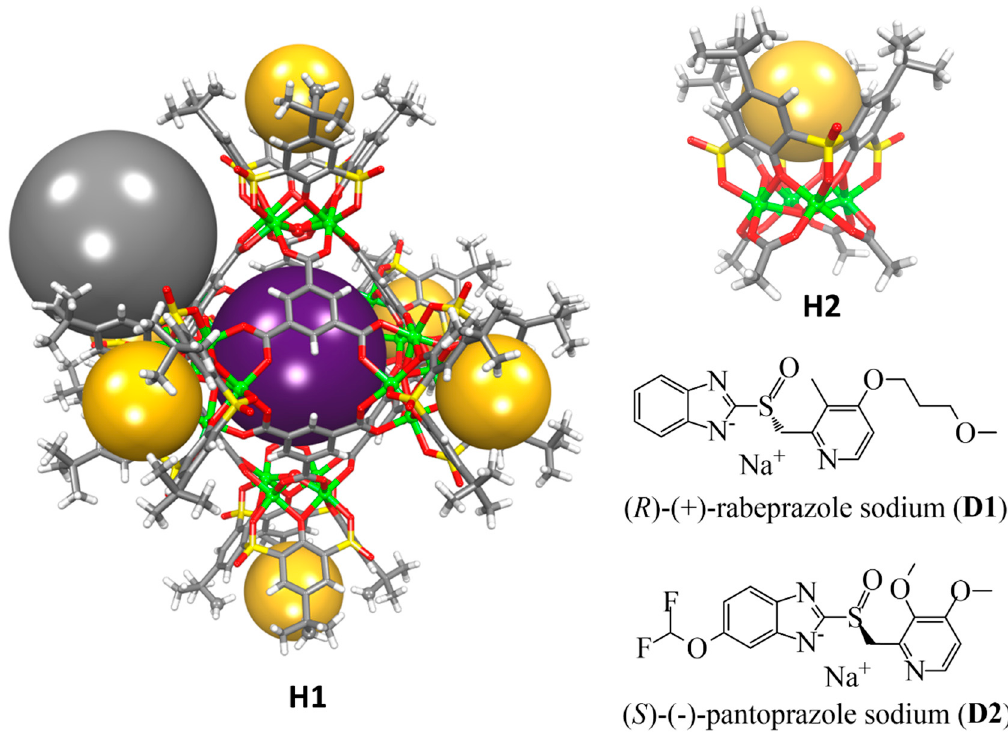
Figure 1. The crystal structures of host molecules ( H1 and H2 ) based on the CIF files reported in the original literature [18,30] and chemical structure diagrams of guest molecules ( D1 and D2 ) used in this study. The spheres serve to guide the eyes representing the endo cavity (purple), six exo cavities (yellow), and one of the eight external pockets (gray).